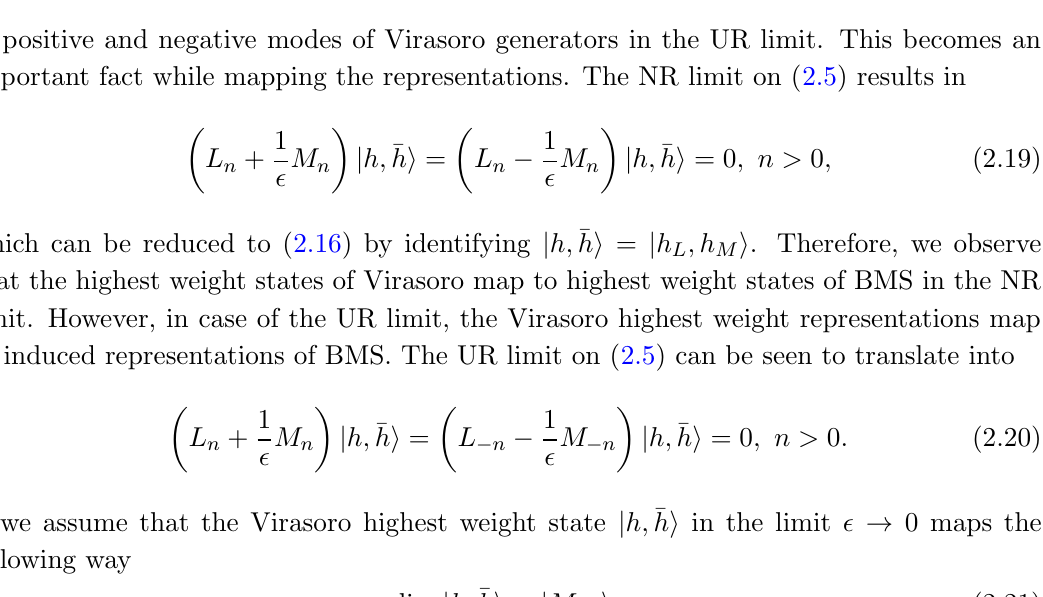
Figure 1 . Mapping of di(cid:11)erent representations in the singular